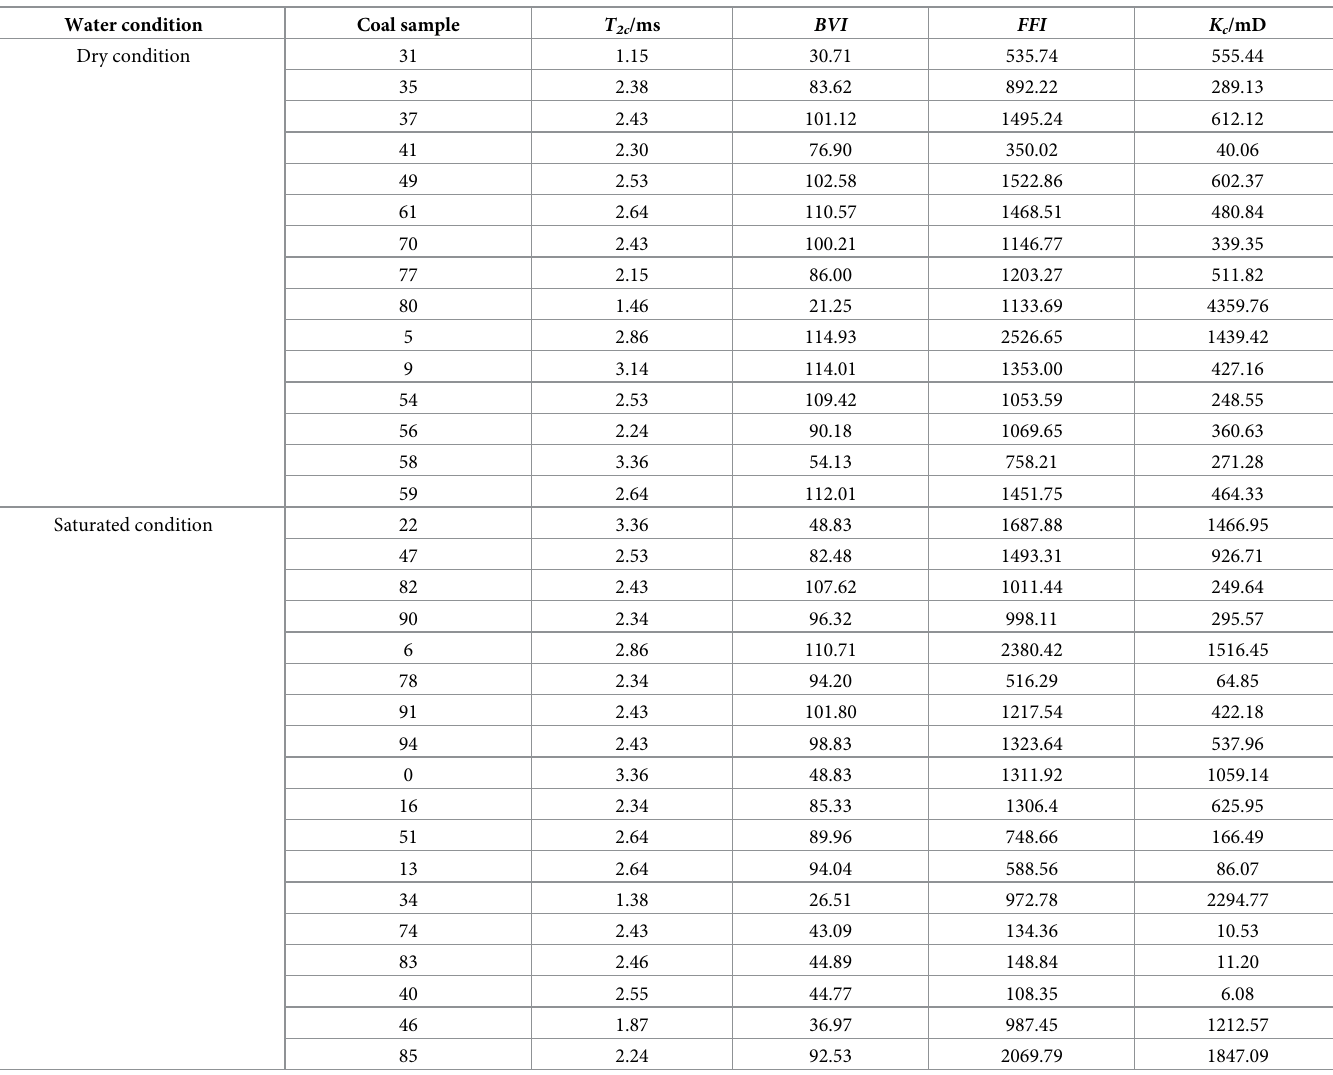
Table 3. NMR data of coal